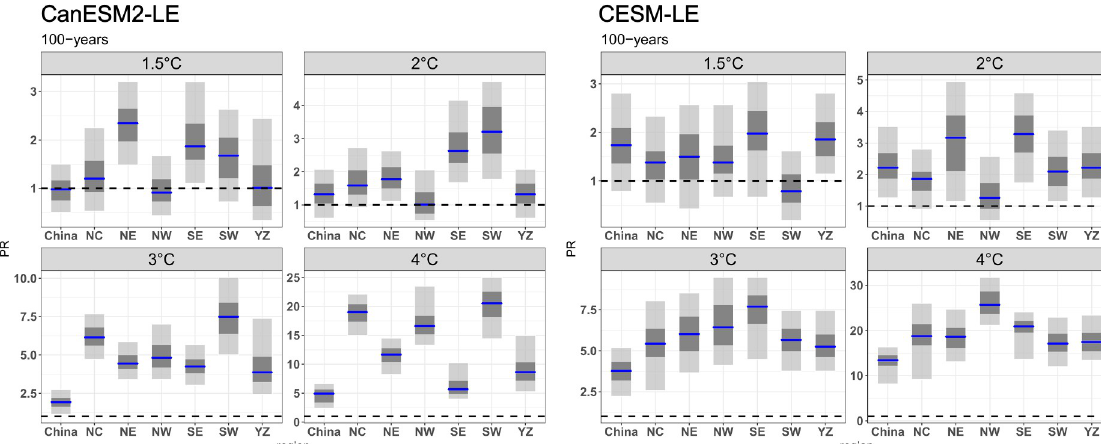
Fig 9. Same as Fig 8, but for the 100-years